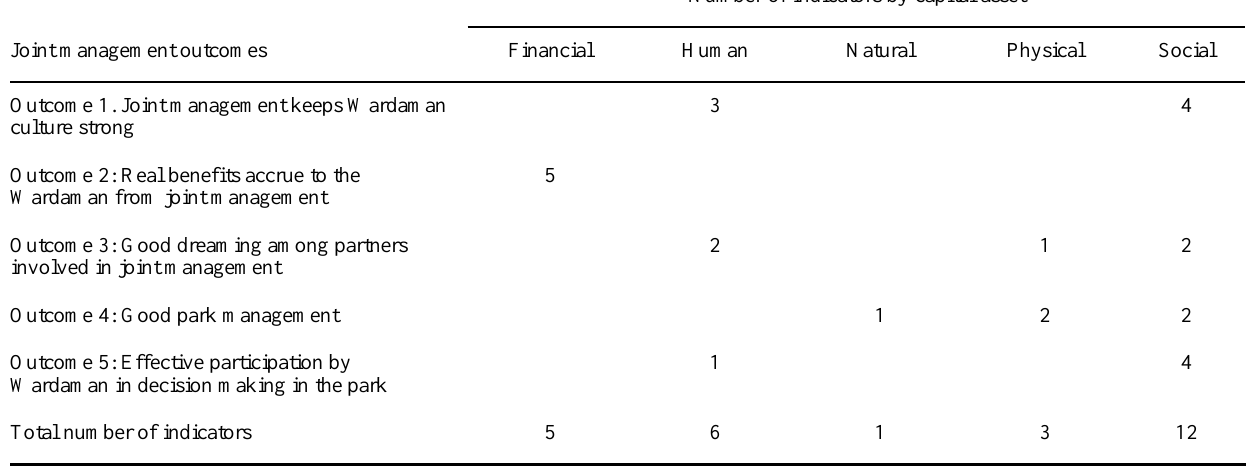
Table 3 . Classification of joint management indicators for Flora River Nature Park against a capital assets framework (Sayer et al.